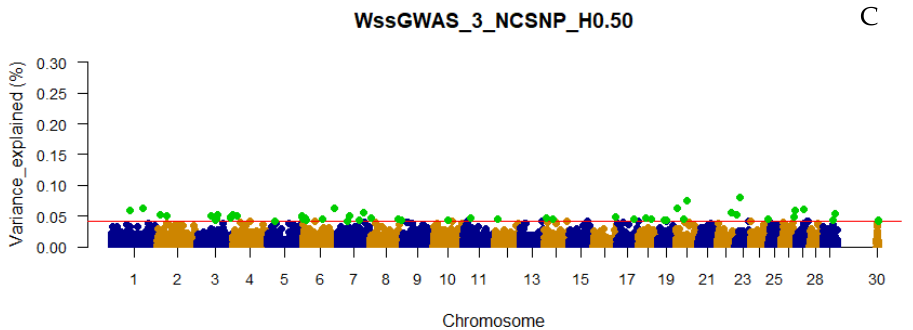
Figure 6. Manhattan plot of the percentage of the total additive genetic variance explained by non-clustered SNPs and haplotypes from haploblocks built with a linkage disequilibrium threshold of 0.50 for yearling temperament in American Angus cattle using single-step GWAS (ssGWAS_NCSNP_H0.50; A ) and weighted single-step GWAS in the second (WssGWAS_2_NCSNP_H0.50; B ) and third (WssGWAS_3_NCSNP_H0.50; C ) iterations. Green points highlighted above the red horizontal line are the top 0.001% markers that explained greater percentages of the total additive genetic variance for YT. The X-chromosome (PAR region) is represented by the chromosome 30.